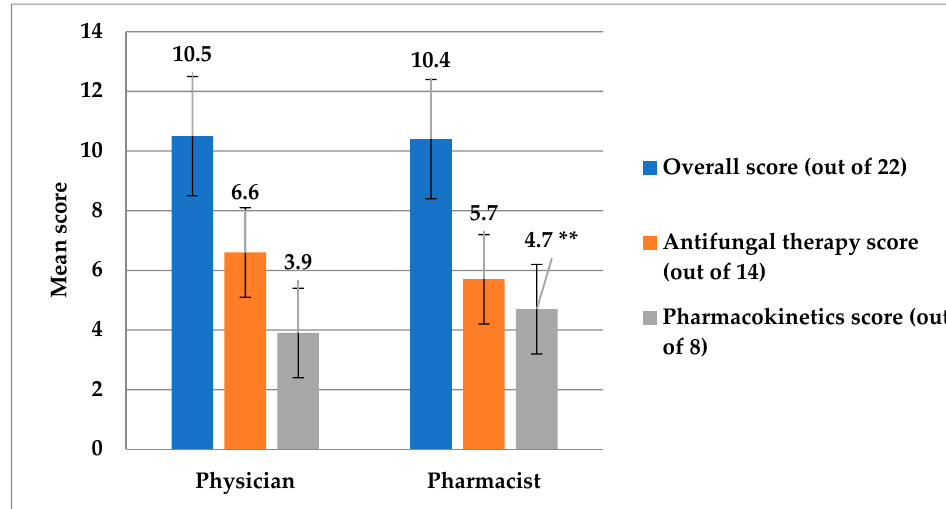
Figure 5. This figure shows the comparison of scores between physicians and pharmacists for the antifungal therapy domain, the pharmacokinetics domain, and the overall knowledge and practice scores. ** The score of pharmacists for the pharmacokinetics domain was significantly higher com- pared to physicians ( p = 0.05).